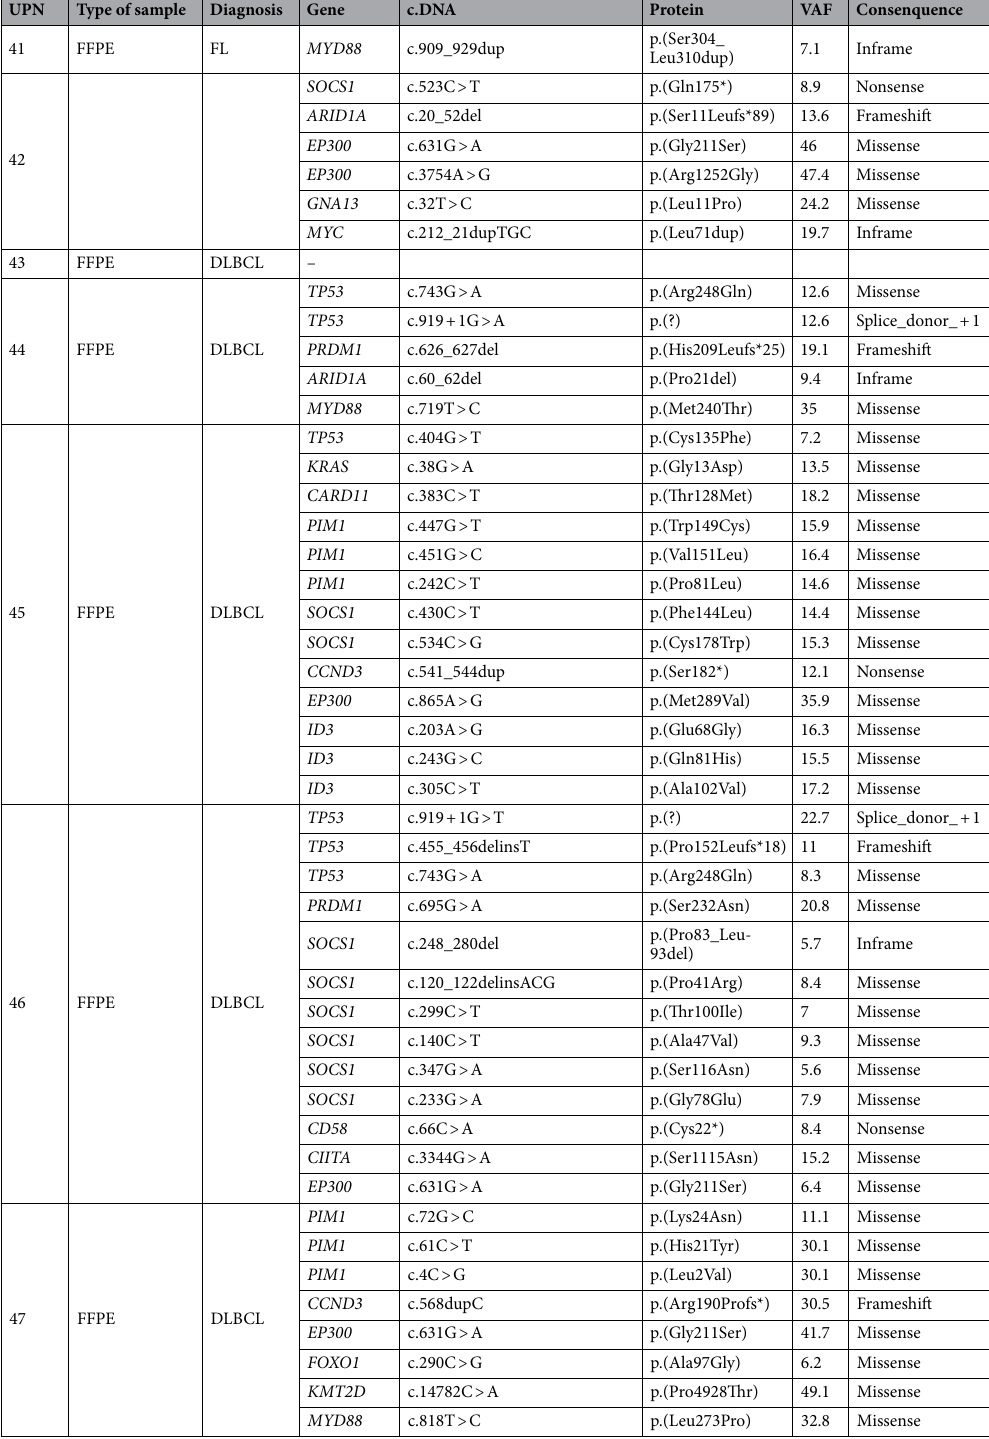
Table 1. Mutational analysis of formalin-fixed paraffin-embedded tissue